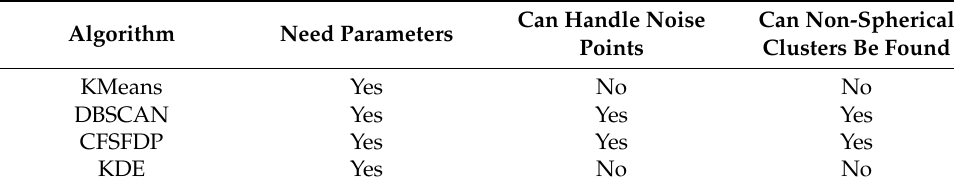
Table 2. Characteristics of four clustering methods.